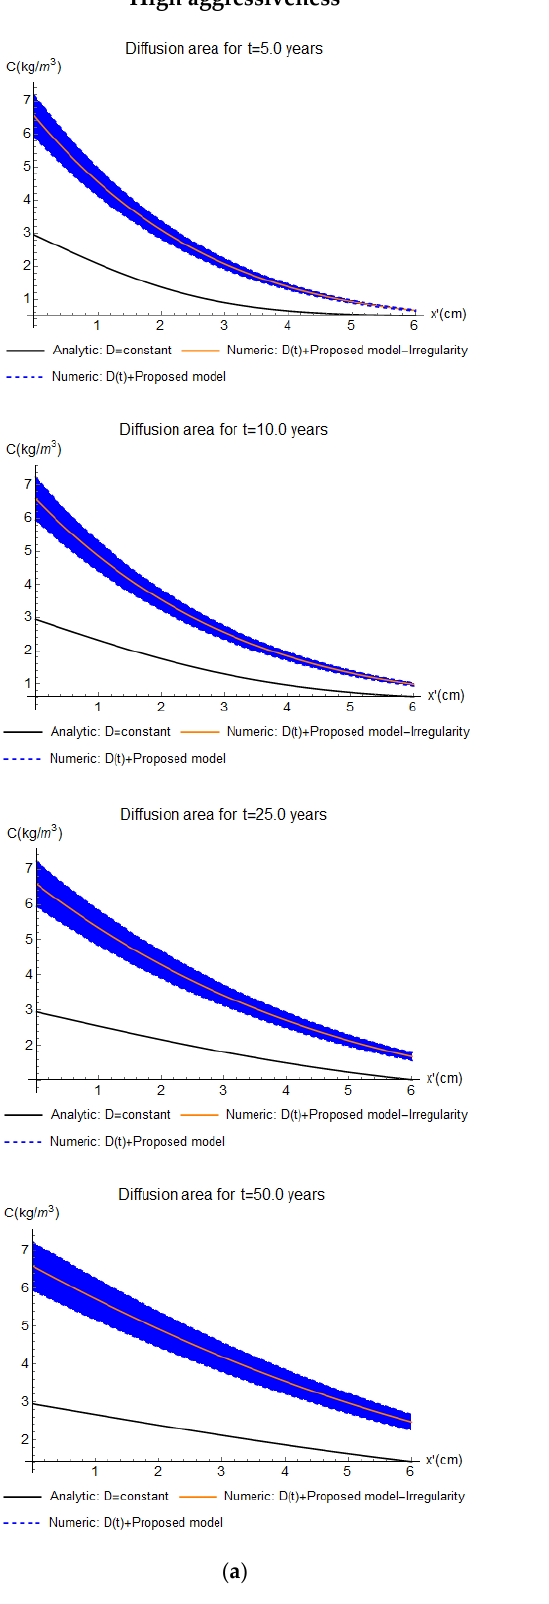
Figure 8. C-x’ curves by analytical and numerical solutions for ( a ) high and ( b ) extreme levels of aggressiveness.